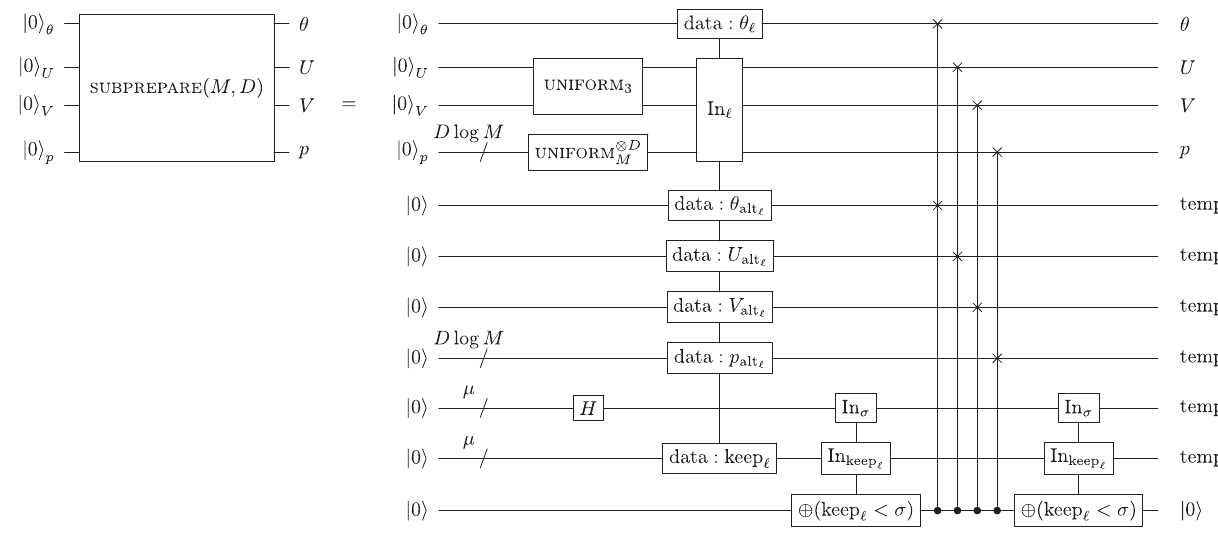
FIG. 15. SUBPREPARE circuit for the electronic structure Hamiltonian, as in Fig. 16, with a T count of 6 N þ O ð μ þ log N Þ and a qubit count of 2 μ þ 3 log N þ O ð 1 Þ , where μ is defined in Eq. (36). The data-loading subroutine is implemented as in Fig. 10 and has a T count of 3 × 4 M 3 − 4 ¼ 6 N − 4 . The UNIFORM subroutine is implemented as in Fig. 12 and has a T count of O ð μ Þ . The compare-and- swap operations have a negligible O ð log N Þ T count. As in Eq. (45), D denotes the system dimension (usually D ¼ 3 ), and M refers to the number of values along each dimension such that N ¼ 2 M D . Although we only specify the behavior of the circuit when the U , V , and p qubits start in the j 0 i state, the circuit is also invoked in contexts where this is not the